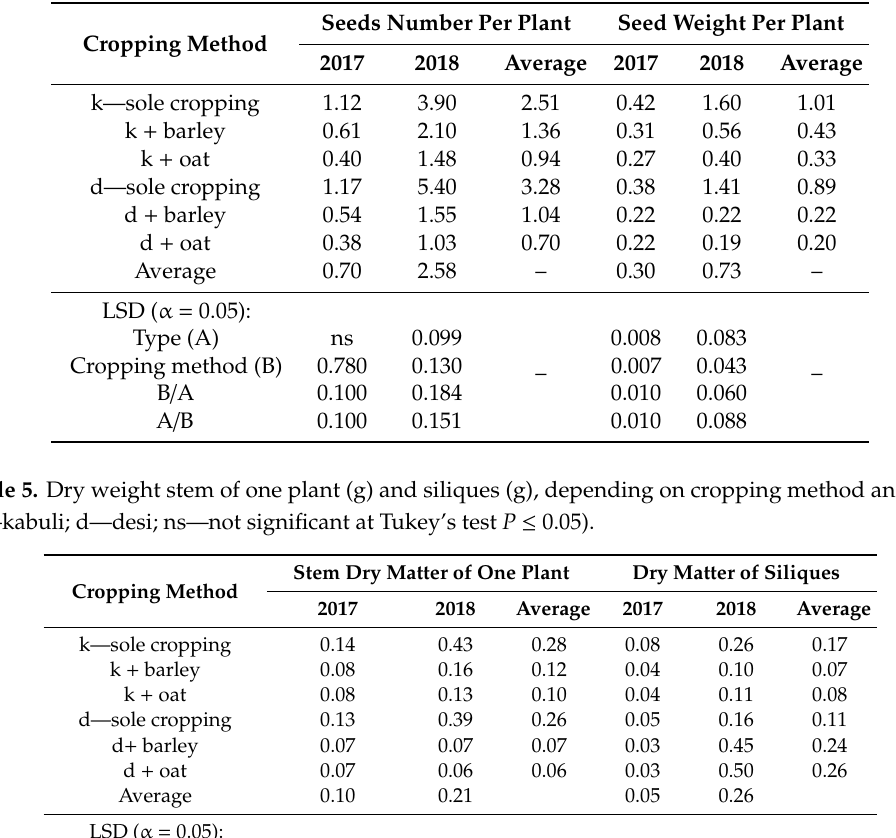
Table 4. Seed weight (g) and number per chickpea plant, depending on cropping method and type